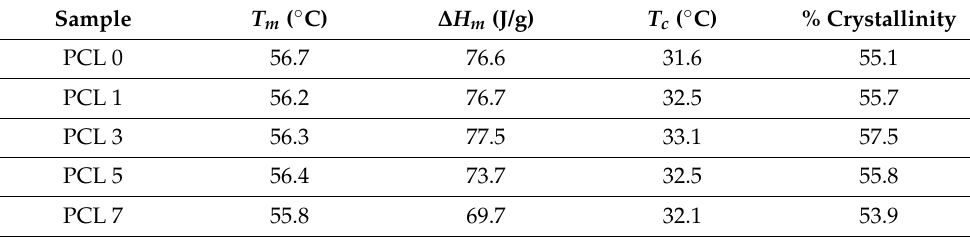
Table 2. Summarized melting and crystallization temperatures and heat of fusion of PCL and PCL/HAP